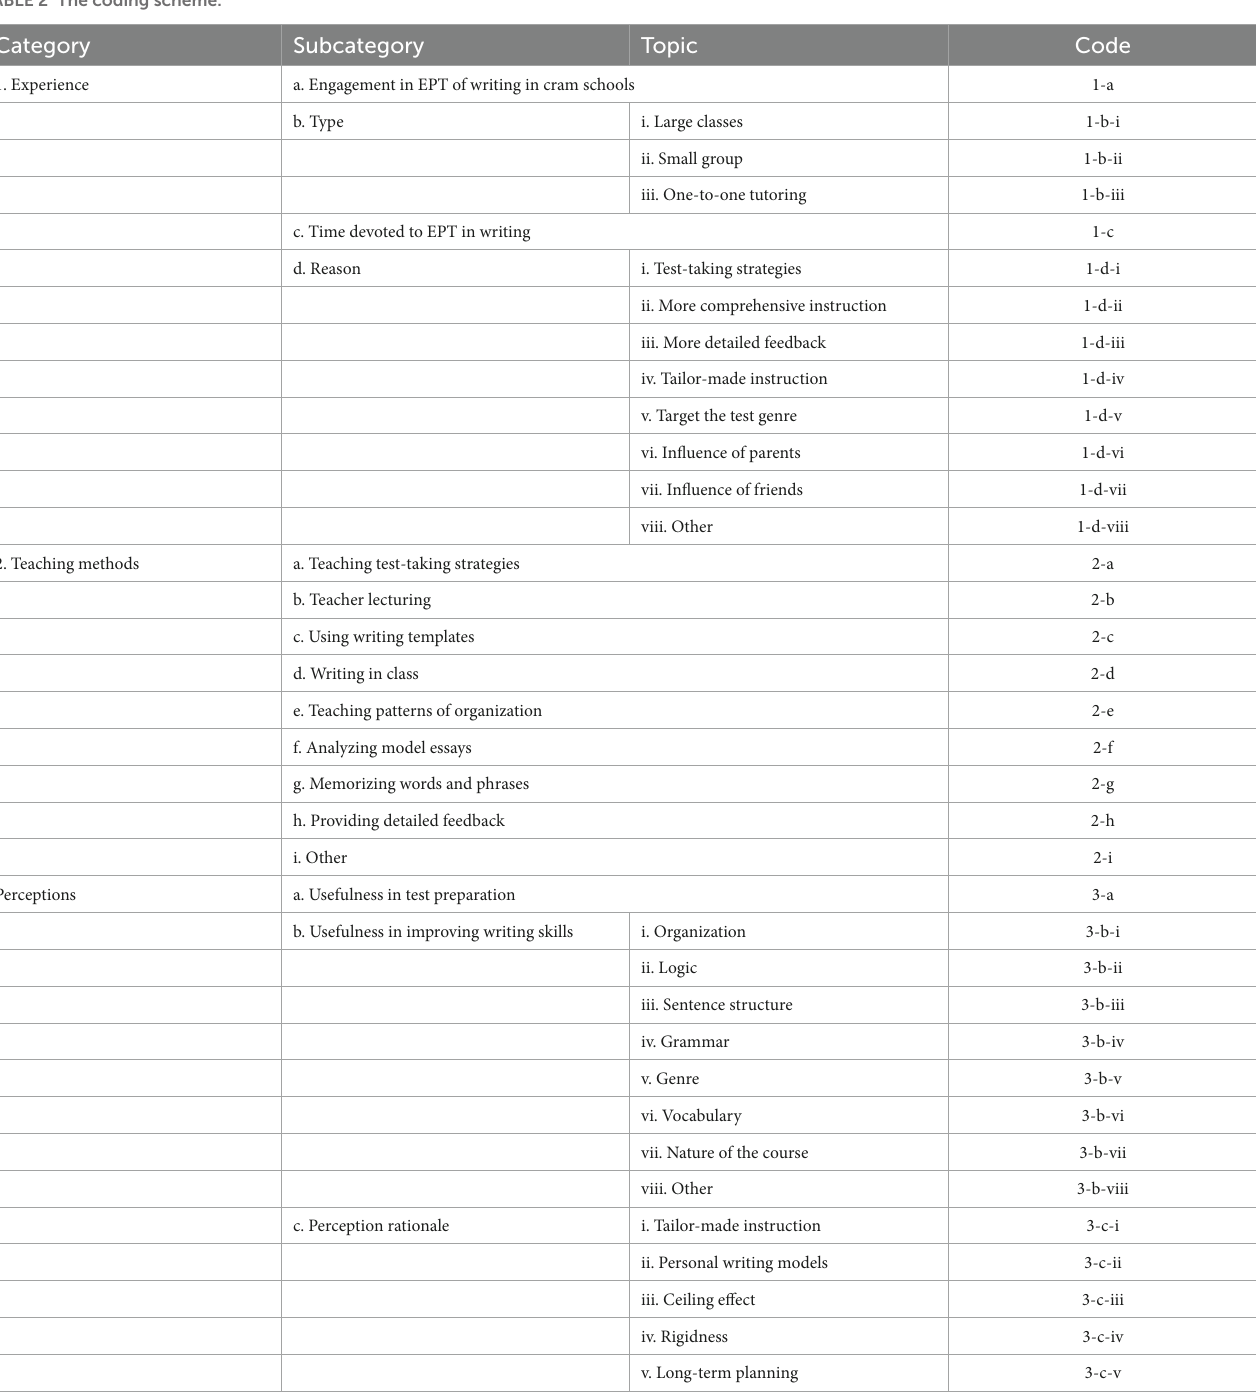
TABLE 2 The coding scheme.